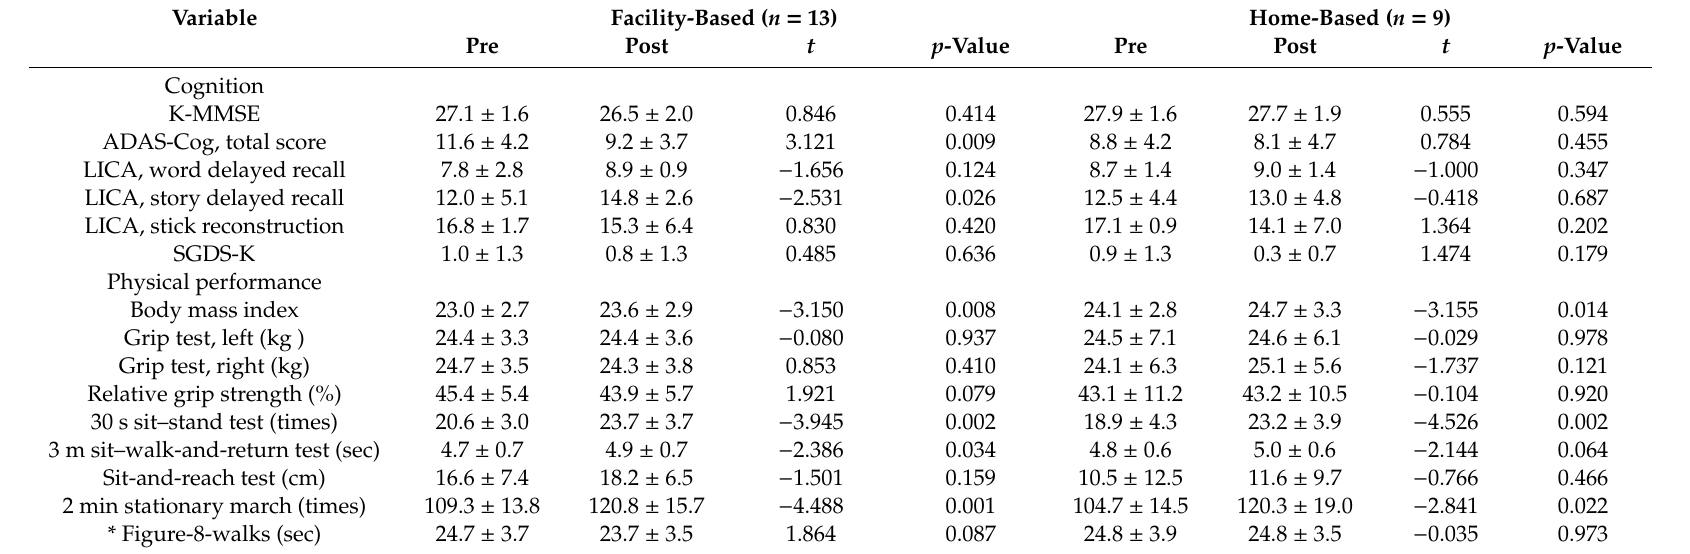
Table 4. Changes in cognitive function and physical fitness after